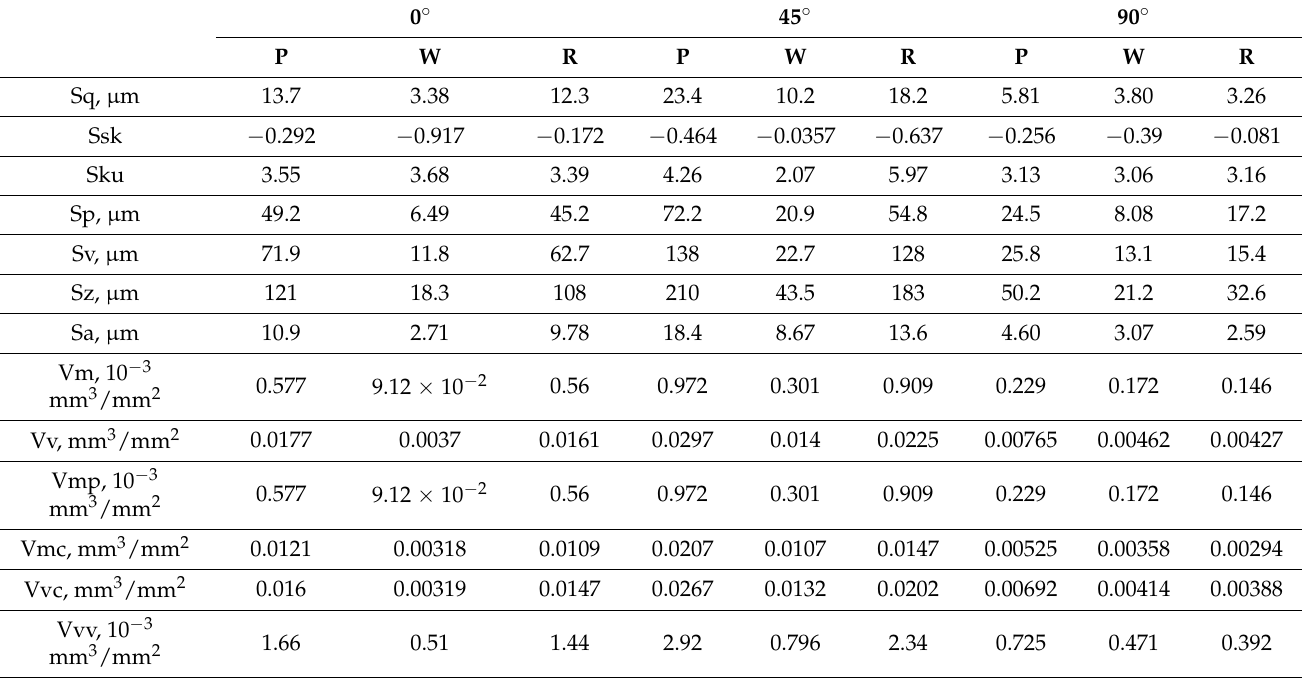
Table 4. Values of selected 3D